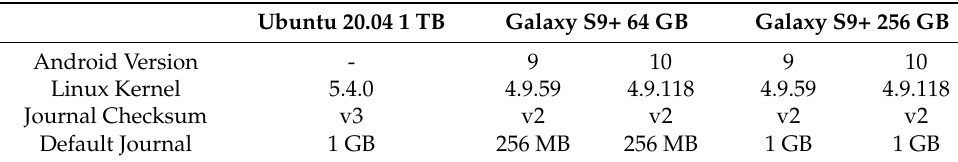
Table 3. Comparison of Android and PC journal